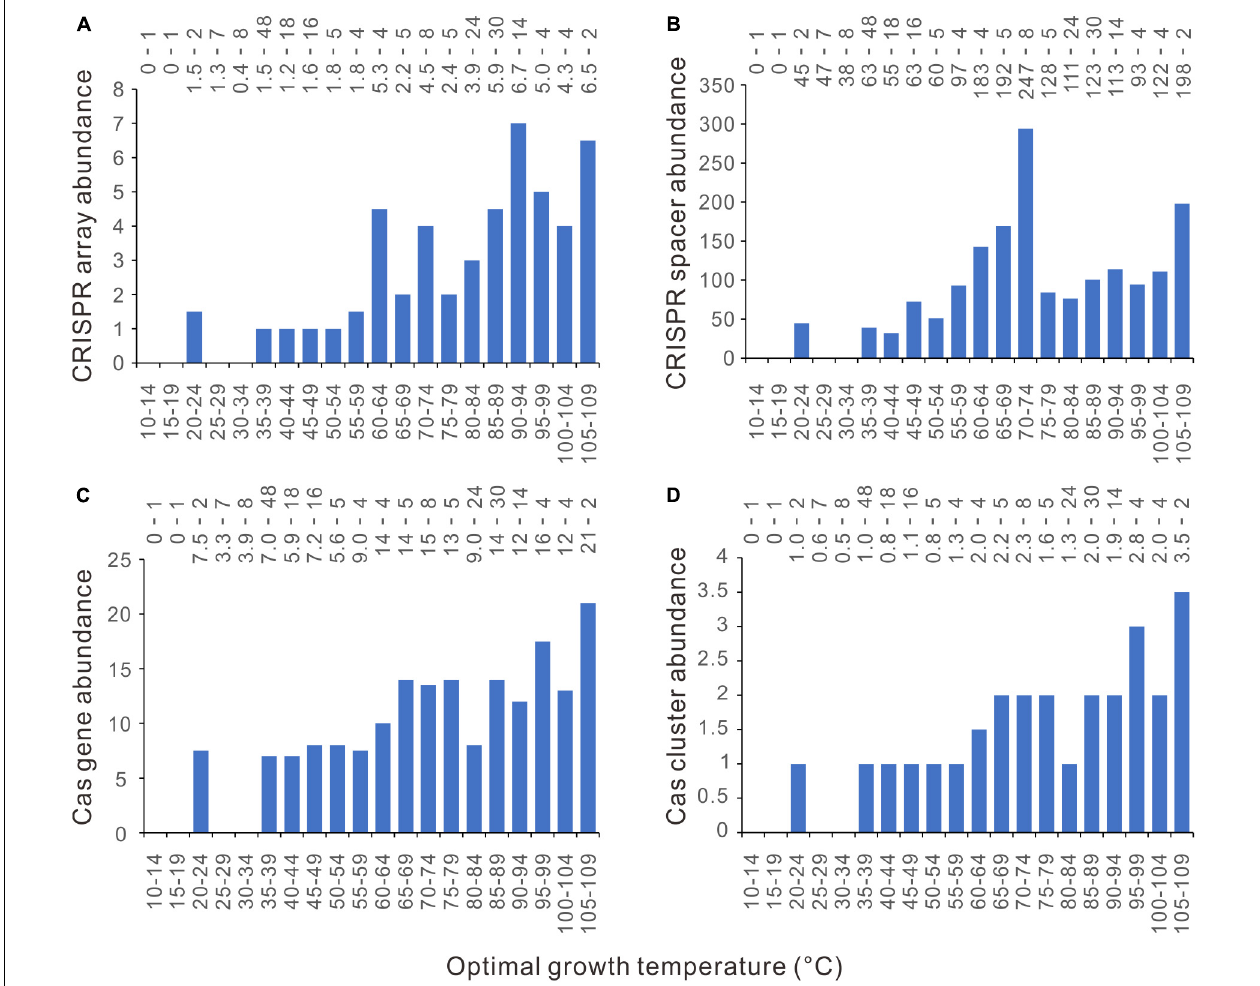
FIGURE 7 | Relationships between archaeal CRISPR-Cas abundances and optimal growth temperatures (Topt). (A) CRISPR arrays. (B) CRISPR spacers. (C) cas genes. (D) cas gene clusters. Because median values are less sensitive to extreme outliers than the mean values, we created the column charts using the median value of each Topt range. The mean value and the number of genomes of each bin (separated by a hyphen) are shown at the top of each